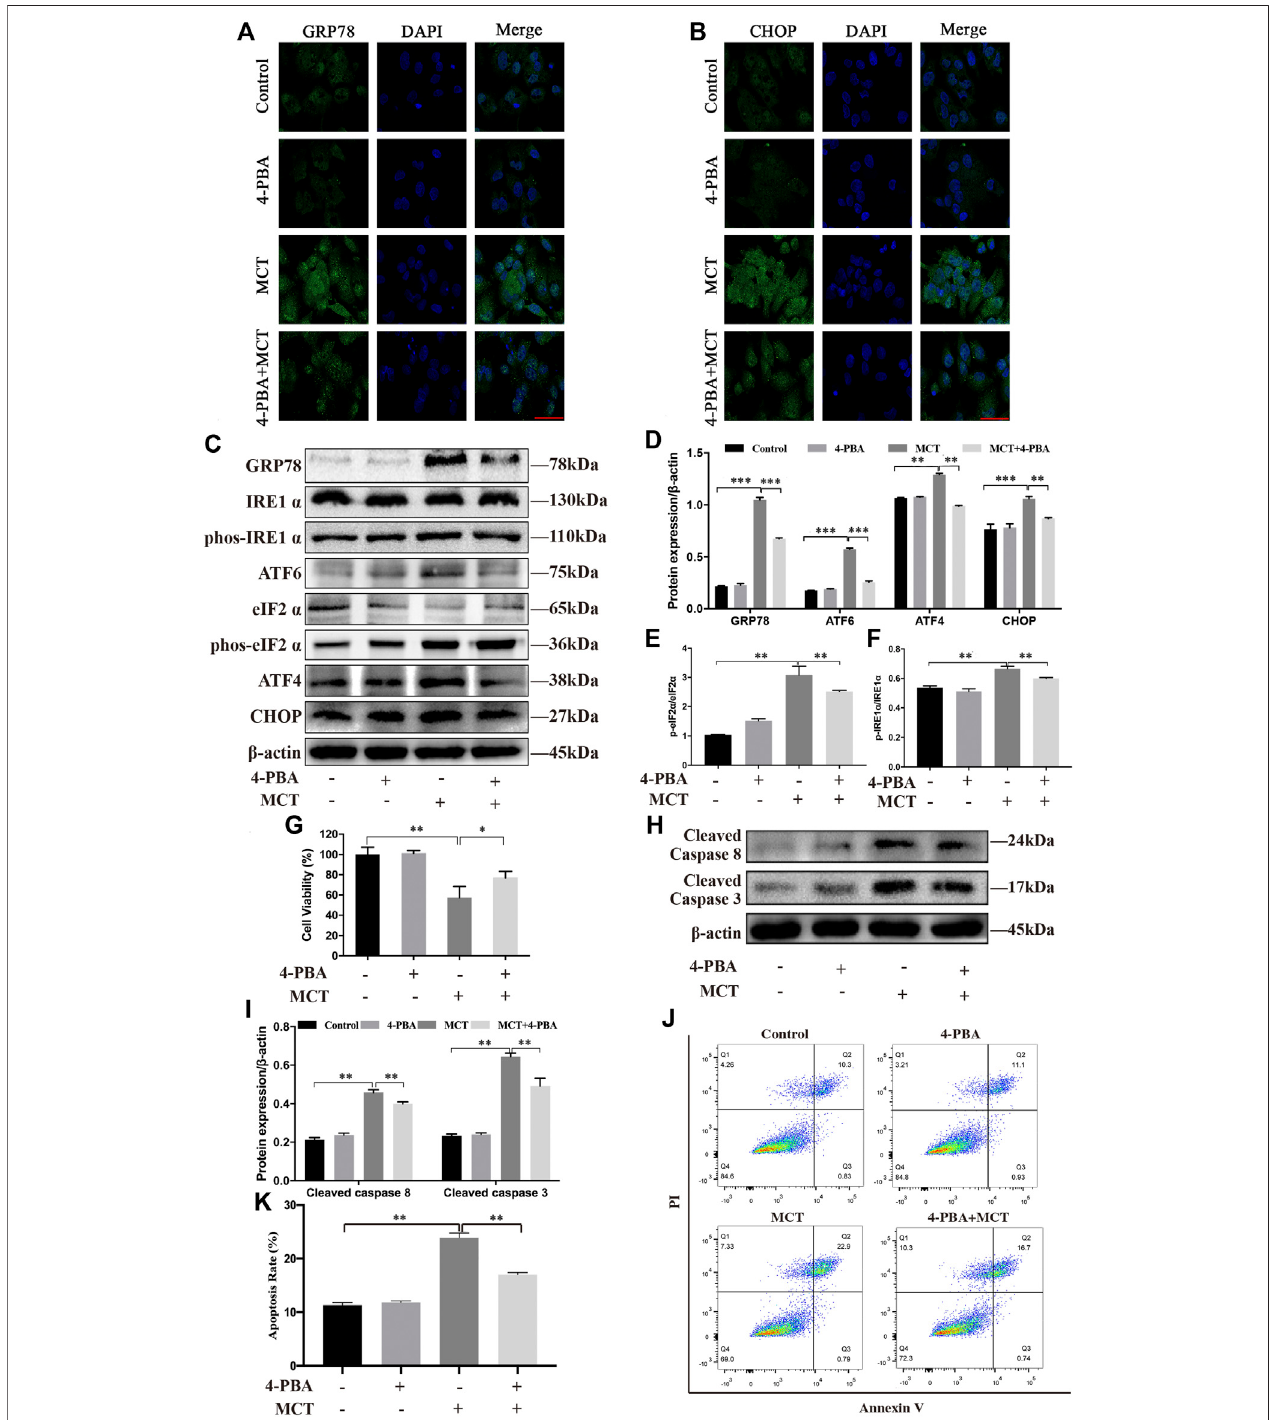
FIGURE 4 | Inhibition of MCT-induced ER stress can partly protect primary rat hepatocytes from apoptosis. After pretreatment with 4-PBA (0.5 mM) for 4 h, the hepatocytes were treated with or without 300 μ M of MCT for another 36 h. (A) Representative immuno fl uorescence photomicrographs showing the location of GRP78 in hepatocytes from different groups. (B) Representative immuno fl uorescence photomicrographs showing the location of CHOP in hepatocytes from different groups. Scalebar (cid:2) 20 μ M. (C) DetectionofERstress-relatedproteins,includingGRP78,IRE1 α ,p-IRE1 α ,ATF6,eIF2 α ,p-eIF2 α ,ATF4,andCHOPbywesternblot. (D – F) Quantitative analysis of protein levels in C. (G) The hepatocytes viability was detected by CCK-8 assay. (H) Representative western blot of cleaved-caspase eight and cleaved-caspase three in hepatocytes. (I) Quantitative analysis of protein levels in G. (J) Representative apoptosis rate measured by Annexin-V/PI staining. The Q1 quadrant stands for cell death induced by mechanical damage or necrotic cells, the Q2 quadrant stands for late apoptosis cells, the Q3 quadrant stands for early apoptosiscells, and the Q4quadrant stands fornormal cells. The sumofcell apoptosis included earlyand late apoptosis cells. (K) The results ofquantitative analyses of apoptosis rate. Data are presented as mean ± SD error of three independent experiments. * p < 0.05, ** p < 0.01, *** p < 0.001 compared to control.